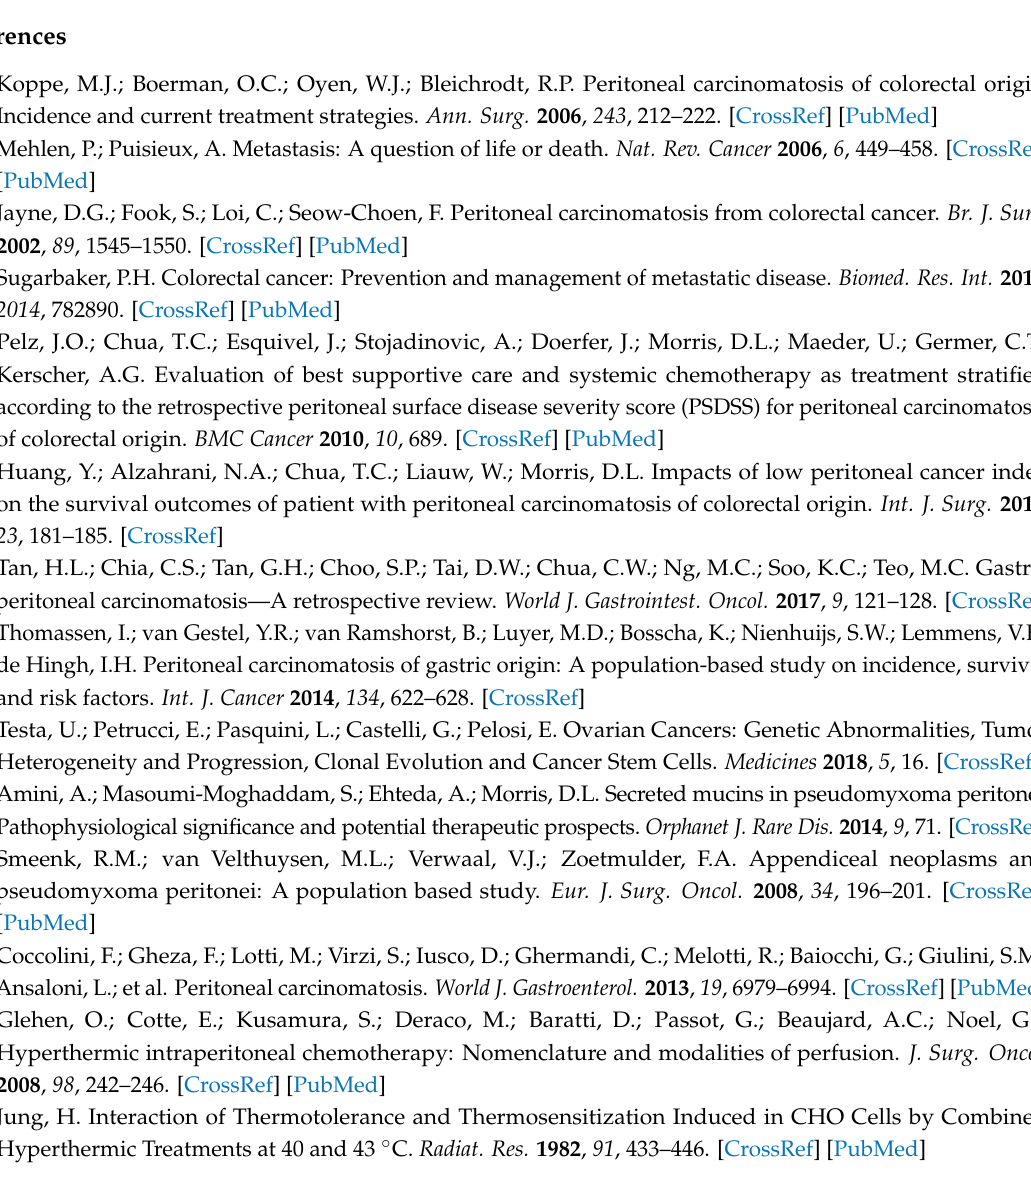
Table S1: CRC origin, Table S2: Ovarian origin, Table S3: Gastric origin, Table S4: MPM origin, Table S5: PMP